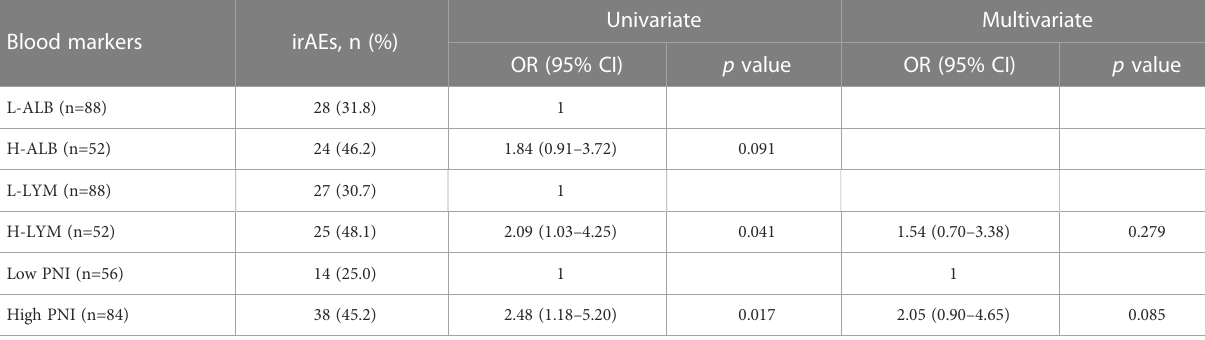
TABLE 4 Levels of peripheral blood markers by irAEs